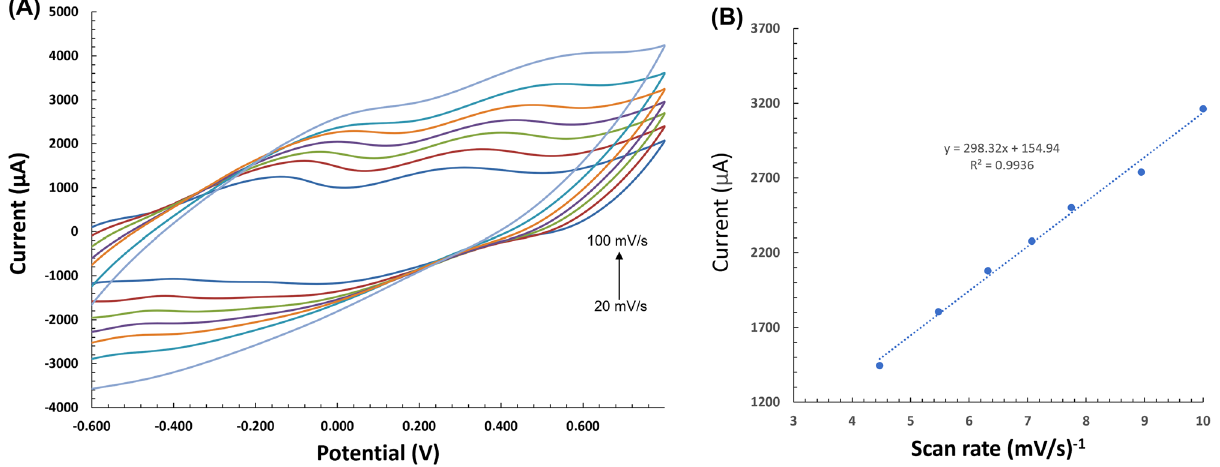
Figure 3. ( A ) Characterization of co–Pt Au anode by cyclic voltammetry at various scan rates in 0.1 M PBS containing 7 mM glucose. ( B ) Corresponding linear relationship between the anodic peak currents and square root of the scan rate.